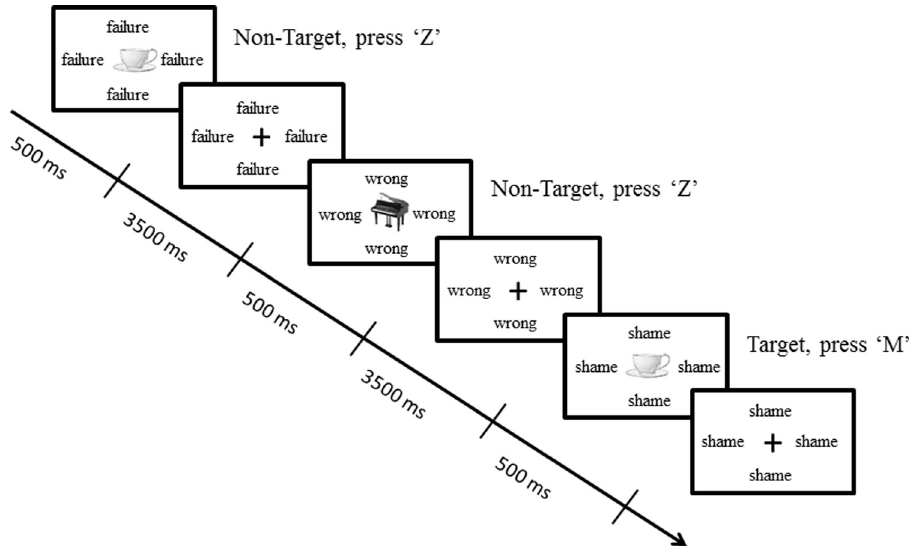
Fig 1. Illustration of the n -back task with emotional word distracters, depicting an example of a 2-back memory- load condition with negative word-distracters. Participants had to press the “M” key when the picture was the same as two pictures before while they had to press the “Z” key for the rest of the